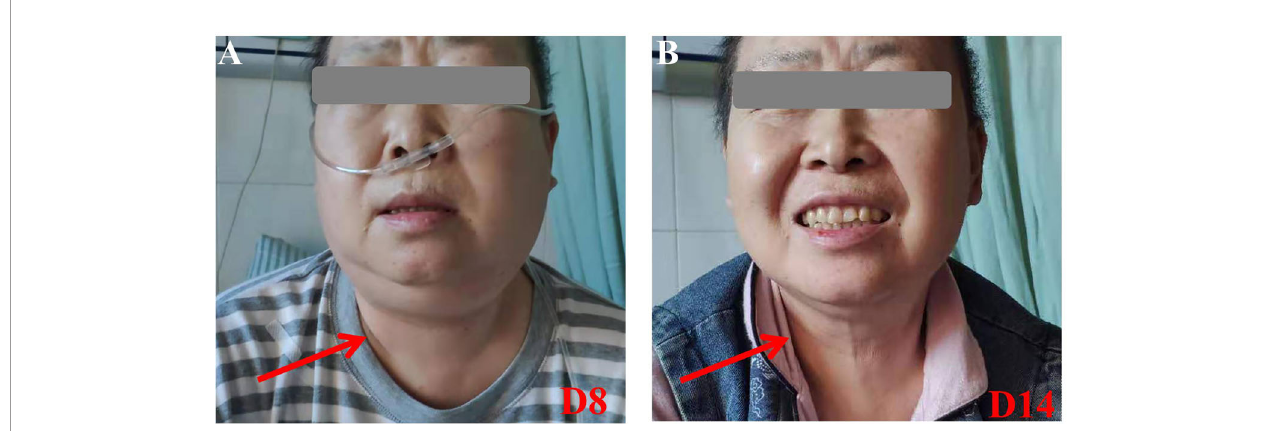
FIGURE 1 | Pictures of the cervical region. (A) At D8, her cervical region was obviously swollen. (B) At D14, her cervical region returned to normal. With consent to publish from the patient.